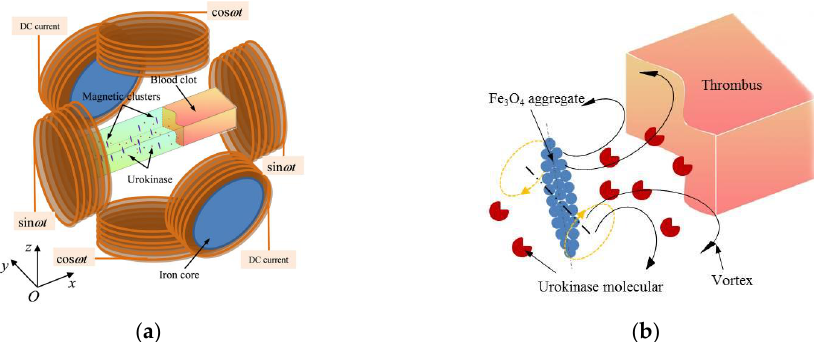
Figure 2. ( a ) Schematic of the magnetic control system; ( b ) The diffusion of urokinase is manipulated by the vortex induced by the rotation of rotating magnetic field (RMF)-guided aggregates.